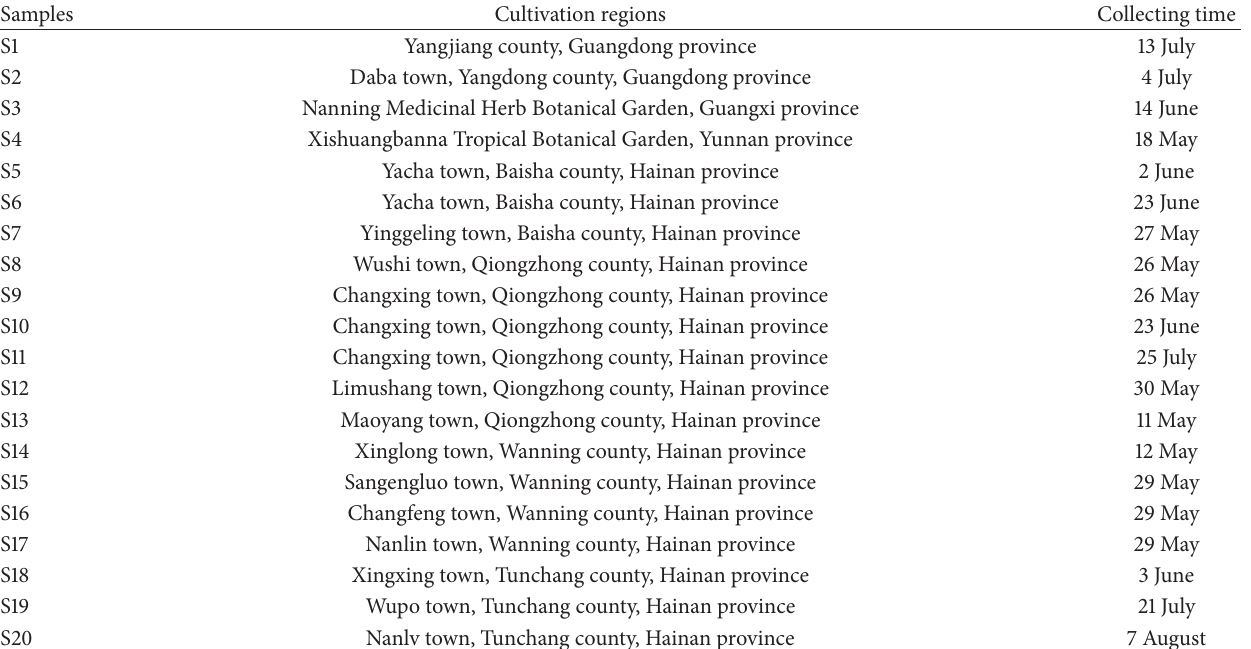
Table 1: The samples of Alpinia oxyphylla Miq. from different cultivation regions. Samples Cultivation regions Collecting